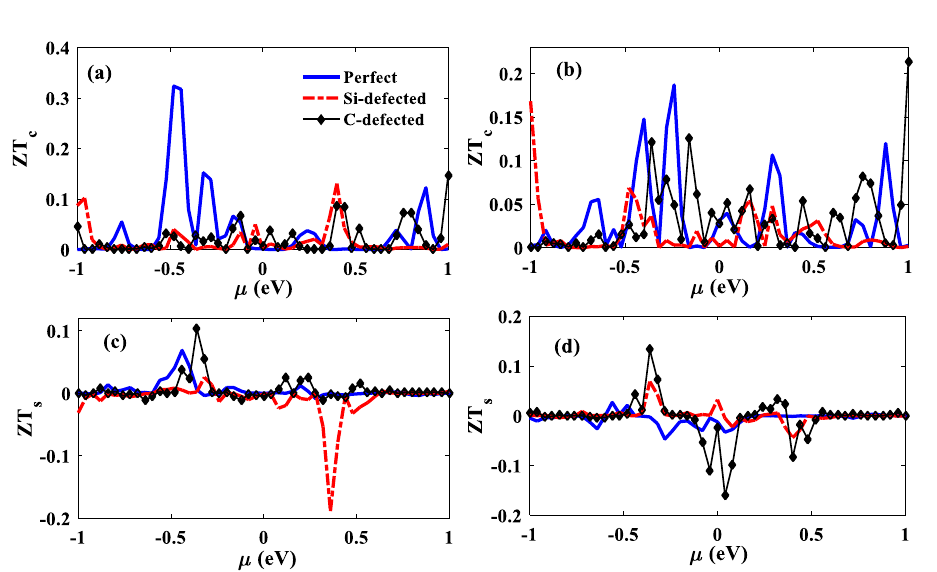
Figure 9. The charge thermoelectric efficiency, ZT c , and the spin thermoelectric efficiency, ZT s , of the perfect (solid lines), Si-defected (dot-dashed lines) and C-defected (lines with diamonds) junctions as a function of chemical potential for P ( a and c ) and AP ( b and d ) electrodes